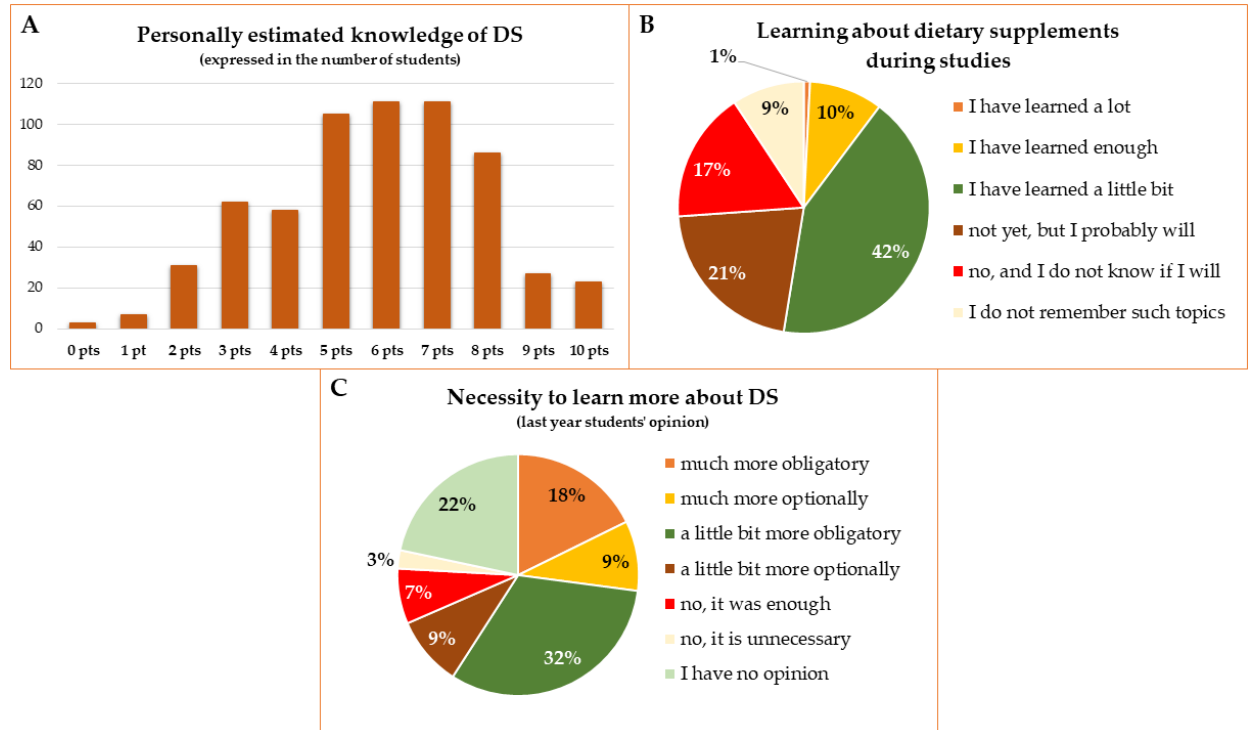
Figure 8. The level of knowledge about DS self-assessed by the students (0—I do not know anything, 10—I think I know very much) ( A ), the information given by students about topics concerning dietary supplements ( B ), and opinion of final-year students about the necessity to learn more about dietary supplements during the studies at the Wroclaw Medical University ( C